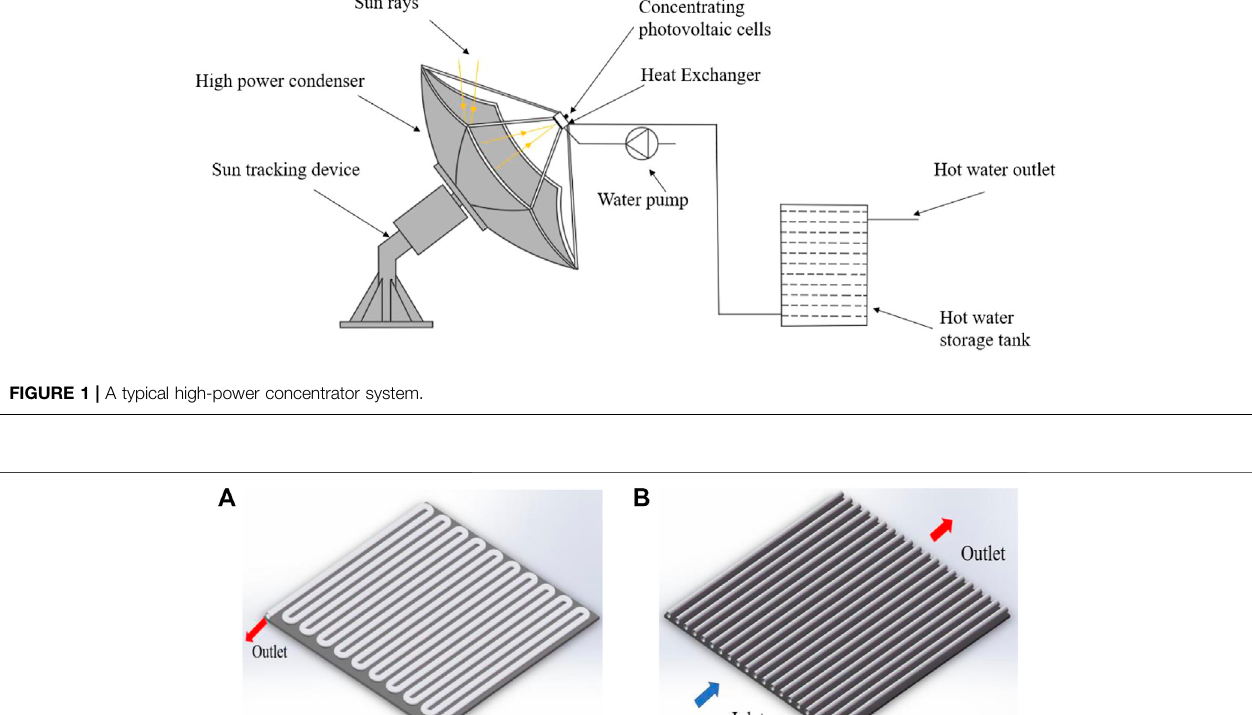
Frontiers in Energy Research |